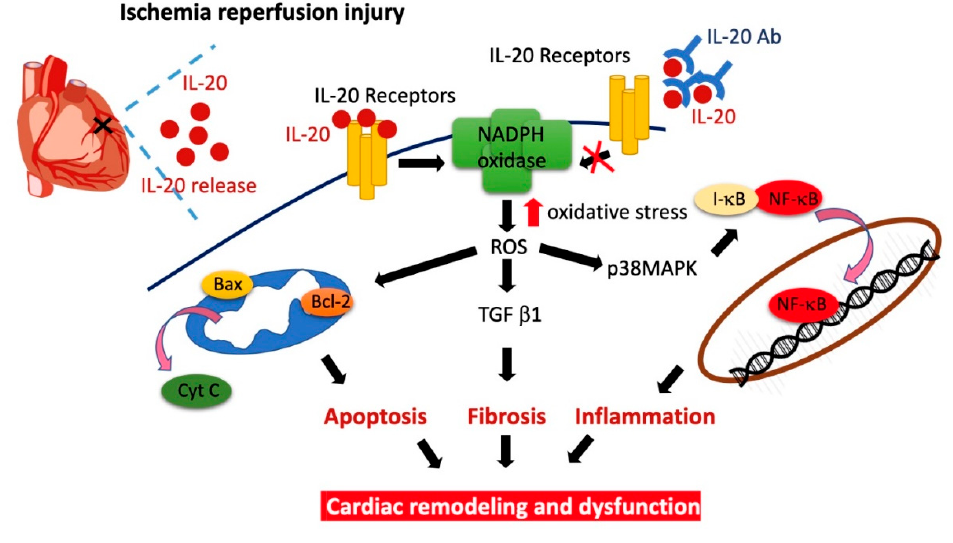
Figure 8. Schematic diagram of the major study findings.